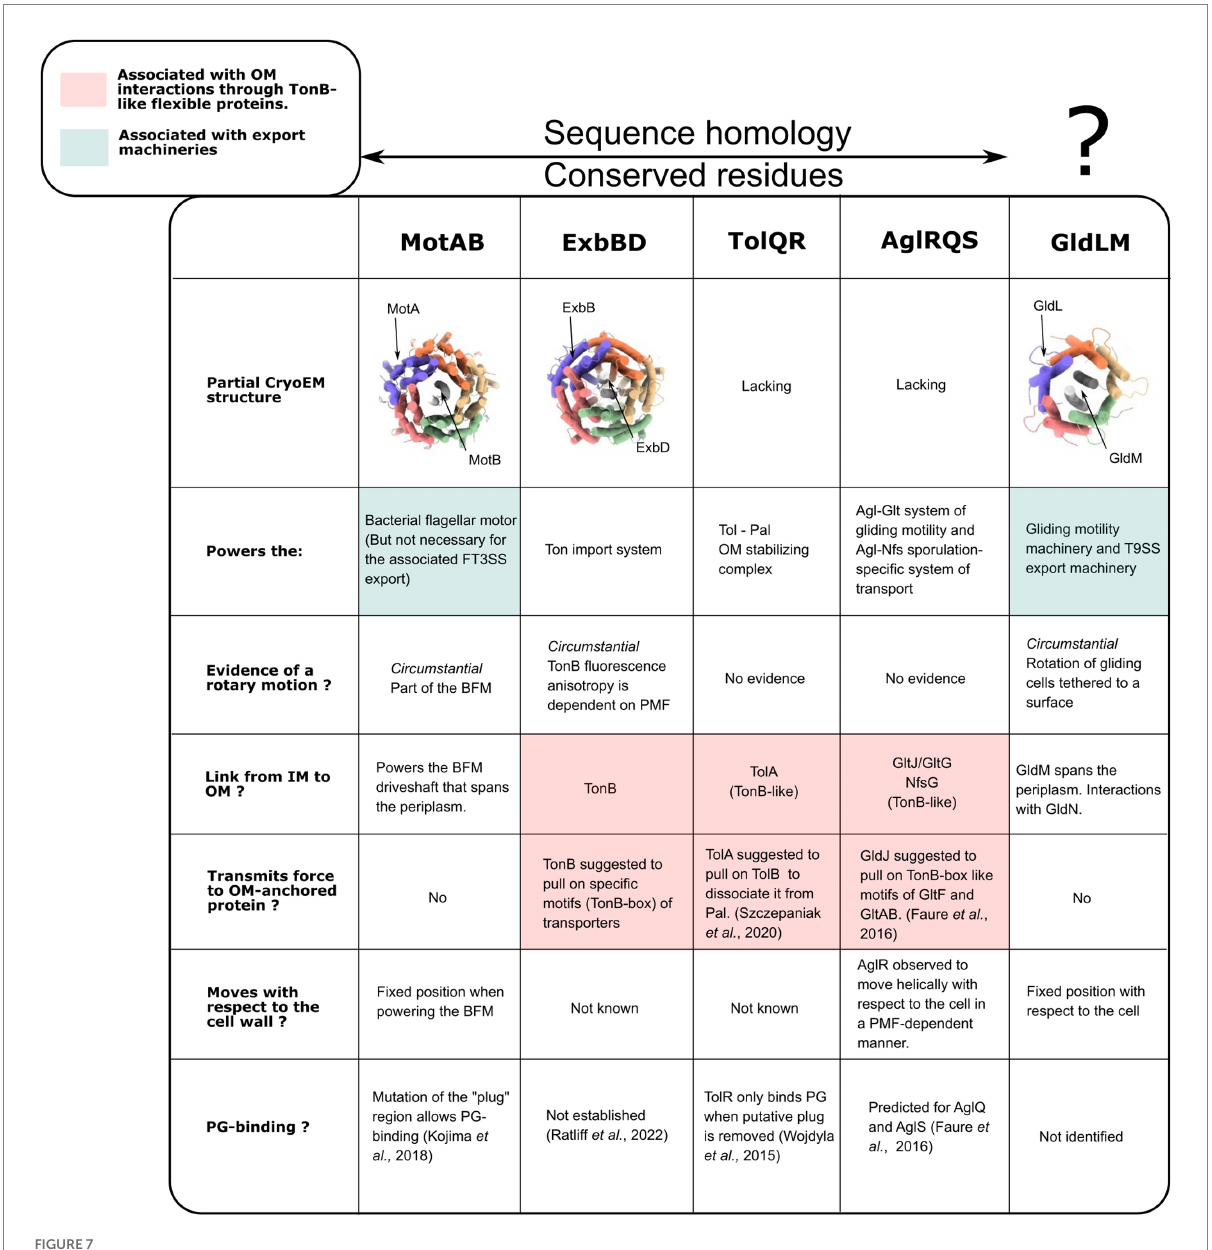
FIGURE 7 Functional comparisons of the PMF-dependent bacterial complexes with known 5:2 structures (MotAB, ExbBD, and GldLM) and their sequence homologs. PDB ID for CryoEM structures, from left to right: 6YKP, 7AJQ, 6YS8. GldLM is reported as lacking sequence homology with other 5:2 motors. However a pairwise sequence alignment using EMBOSS Needle and BLOSUM62 showed identity and similarity of ~15 and 31%, respectively, for MotA/GldL, 18 & 30% for MotB/GldM, indicating the possibility that they might be